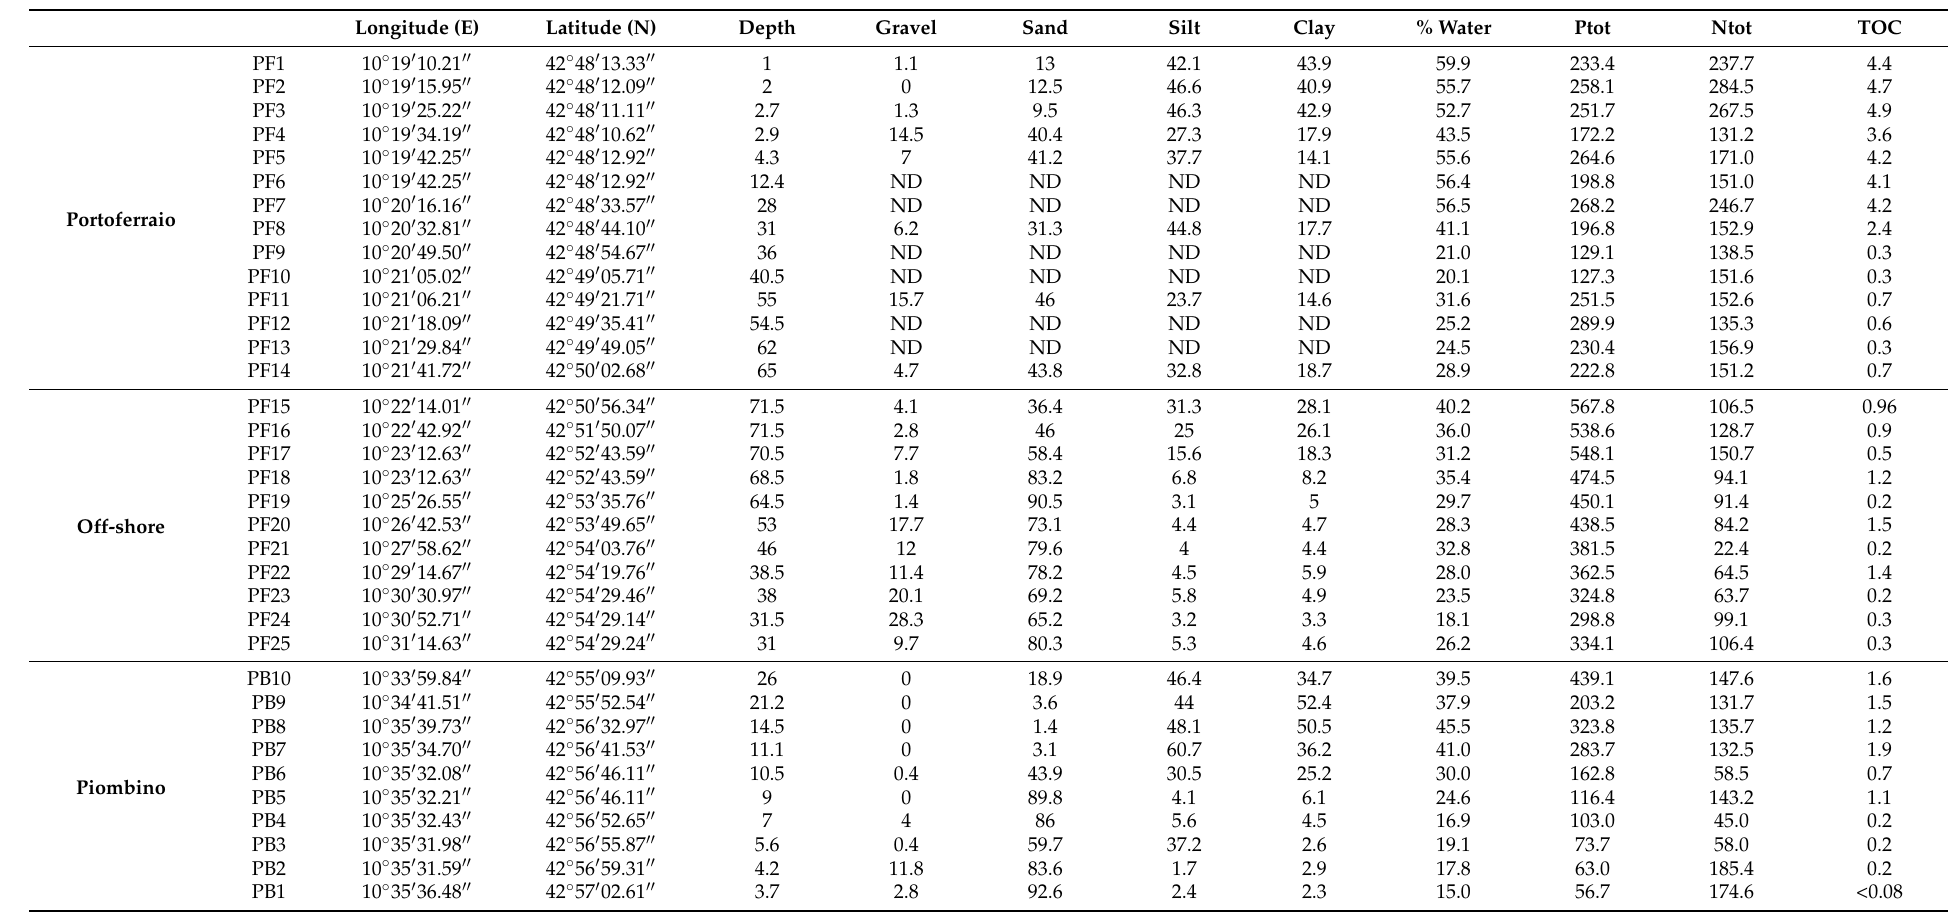
Table A1. Coordinates (WGS84 GMS) and main characteristics of sampling sites: depth (m), grain size (gravel, sand, silt and clay, %), % water (%), total phosphorous (Ptot, mg/kg d.w.), total nitrogen (Ntot, mg/kg d.w.), total carbon (TOC, %). ND = no data available.